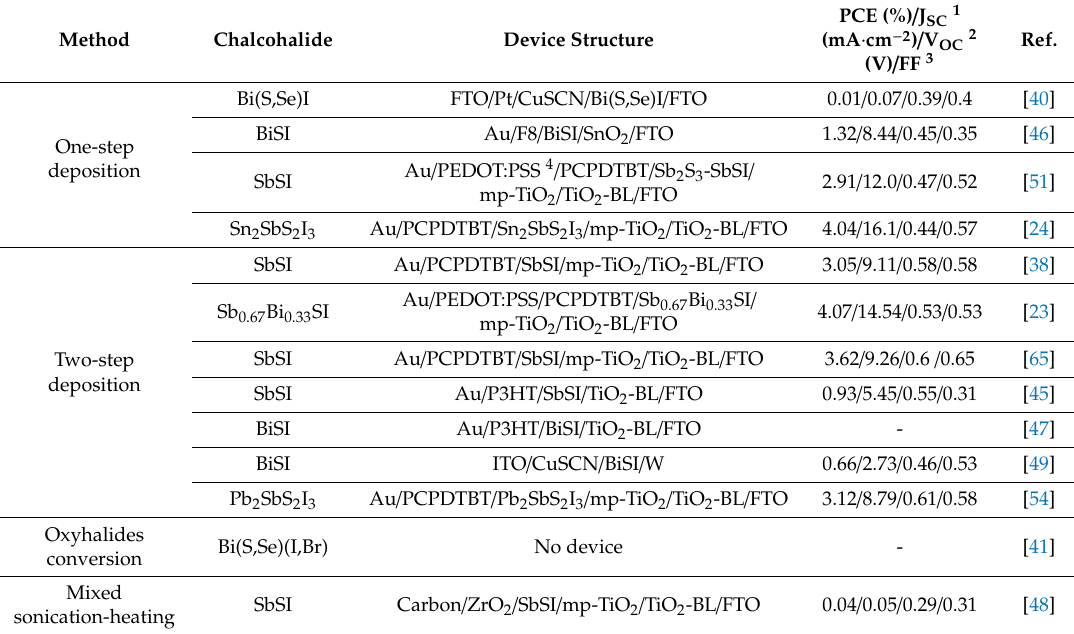
Table 4. Summary of Sb / Bi chalcohalides fabricated for solar cells using varied